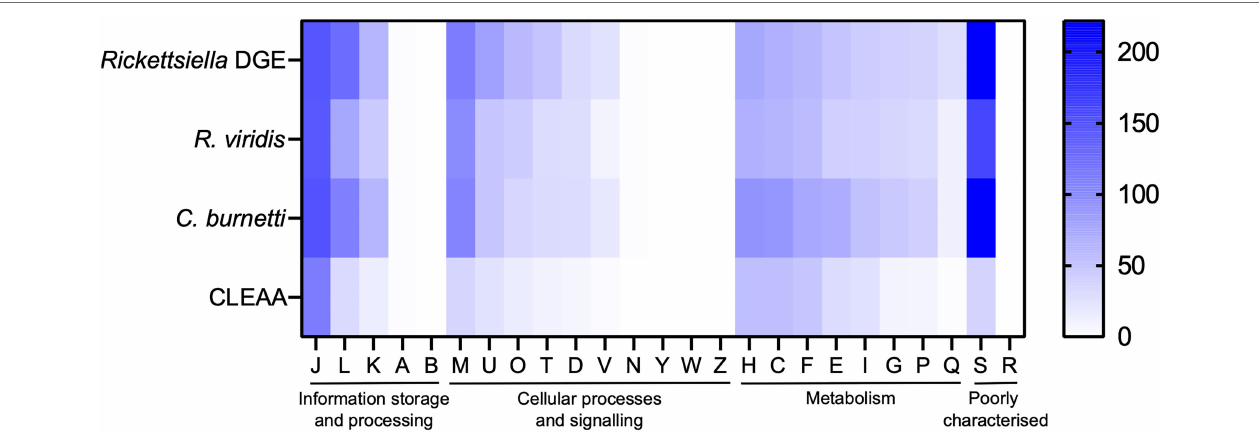
FIGURE 6 | Heatmap comparison of cluster of orthologous groups (COG) frequency in Rickettsiella DGE and related bacteria. Abbreviations for functional categories are as follows: J, translation, ribosomal structure, and biogenesis; L, replication, recombination, and repair; K, transcription; A, RNA processing and modification; B, chromatin structure and dynamics; M, cell wall/membrane/envelope biogenesis; U, intracellular trafficking, secretion, and vesicular transport; T, signal transduction mechanisms; O, posttranslational modification, protein turnover, chaperones; D, cell cycle control, cell division, chromosome partitioning; V, defense mechanisms; N, cell motility; Y, nuclear structure; W, extracellular structures; Z, cytoskeleton; H, coenzyme transport and metabolism; C, energy production and conversion; F, nucleotide transport and metabolism; E, amino acid transport and metabolism; I, lipid transport and metabolism; G, carbohydrate transport and metabolism; P, inorganic ion transport and metabolism; Q, secondary metabolites biosynthesis, transport, and catabolism; S, function unknown; and R, general function prediction only. Scale bar (0, white; 200, blue) indicates number of COGs in each